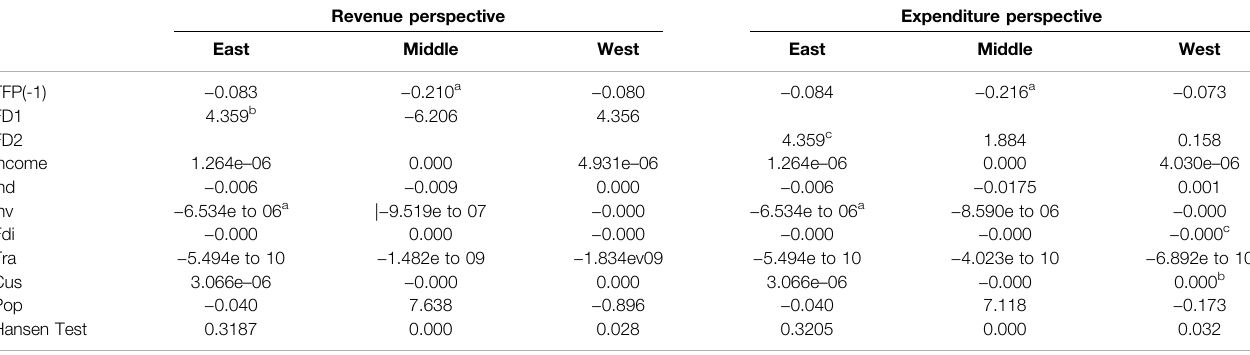
TABLE 5 | Results of weight heterogeneity regression.